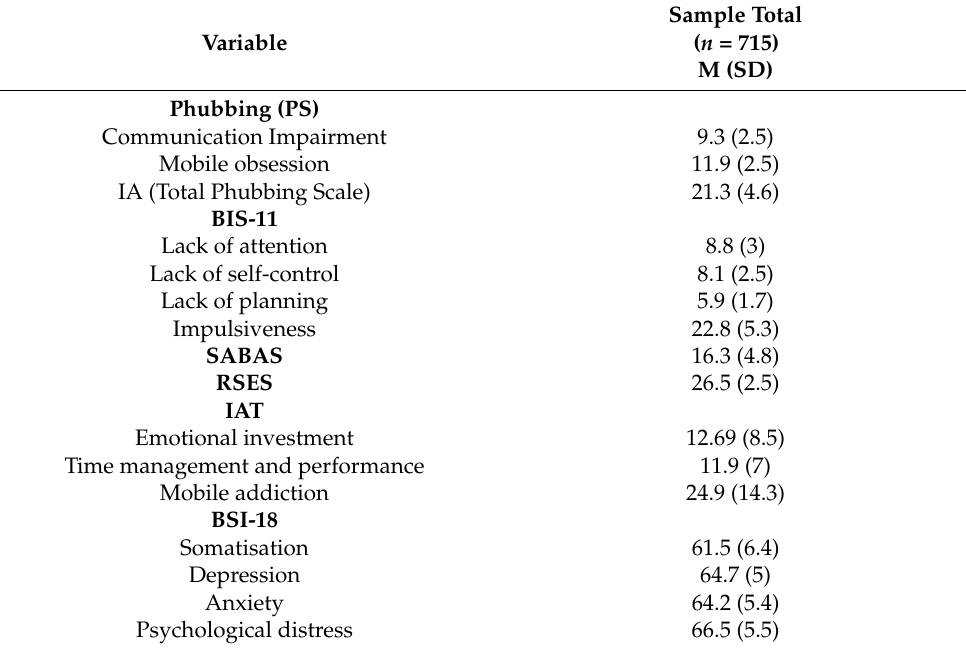
Table 3. Internet addiction scores in the total sample ( n =